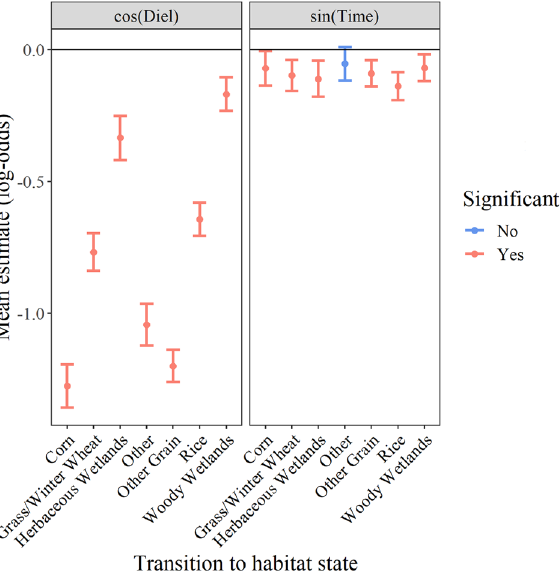
Figure 3. Mean effect on habitat-specific transition probability (± 95% credible intervals; log-odds scale) to each of seven landcover types for time-of-day covariates cos(Diel) and sin(Time). The variable cos(Diel) represents nocturnal and diurnal time periods, while sin(Time) represents the first half (12:00 a.m.–11:59 a.m.) and second half of the day (12:00 p.m.–11:59